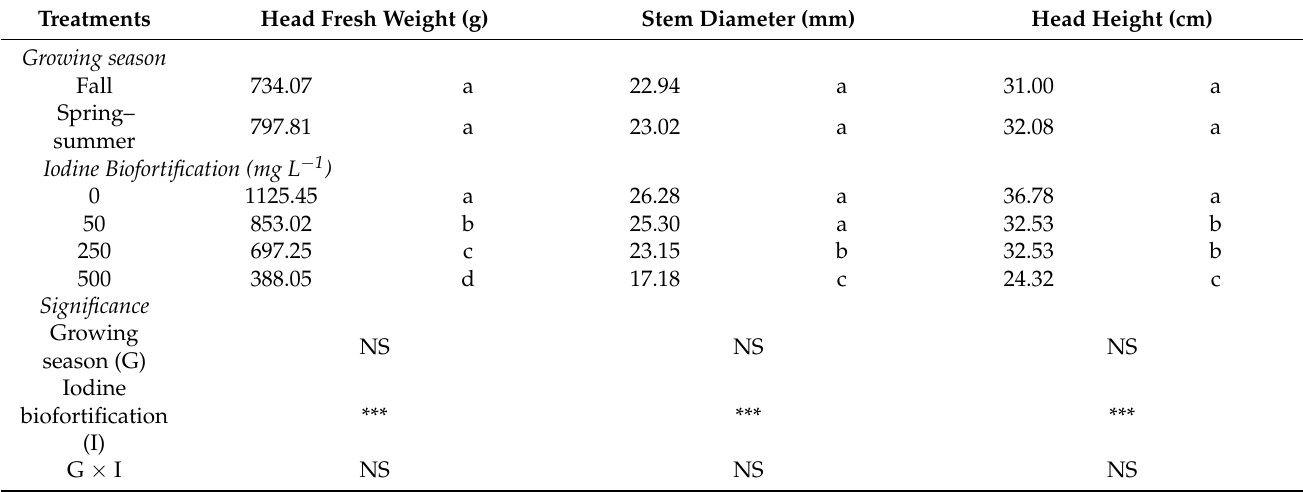
Table 1. Effect of the growing season (fall or spring–summer) and iodine biofortification supply (0, 50, 250 or 500 mg L − 1 ) on head fresh weight, stem diameter, and head height of curly